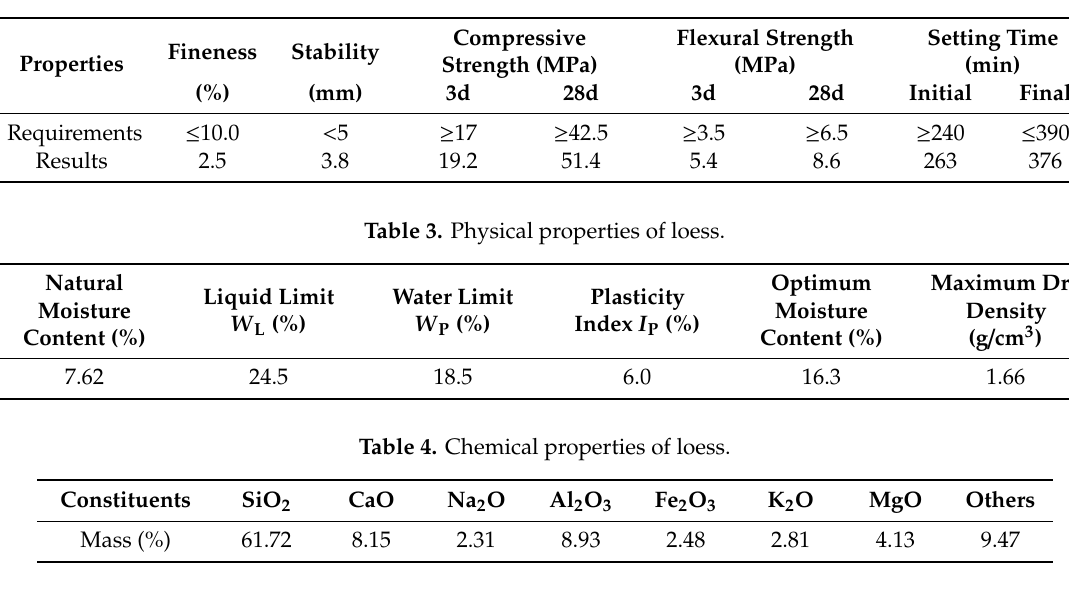
Table 2. Test results of the technical properties of cement.